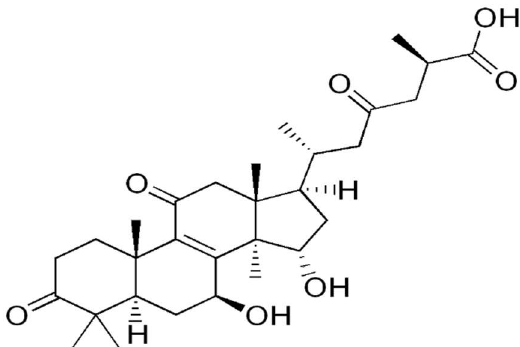
Figure 2. Ganoderic acid A.